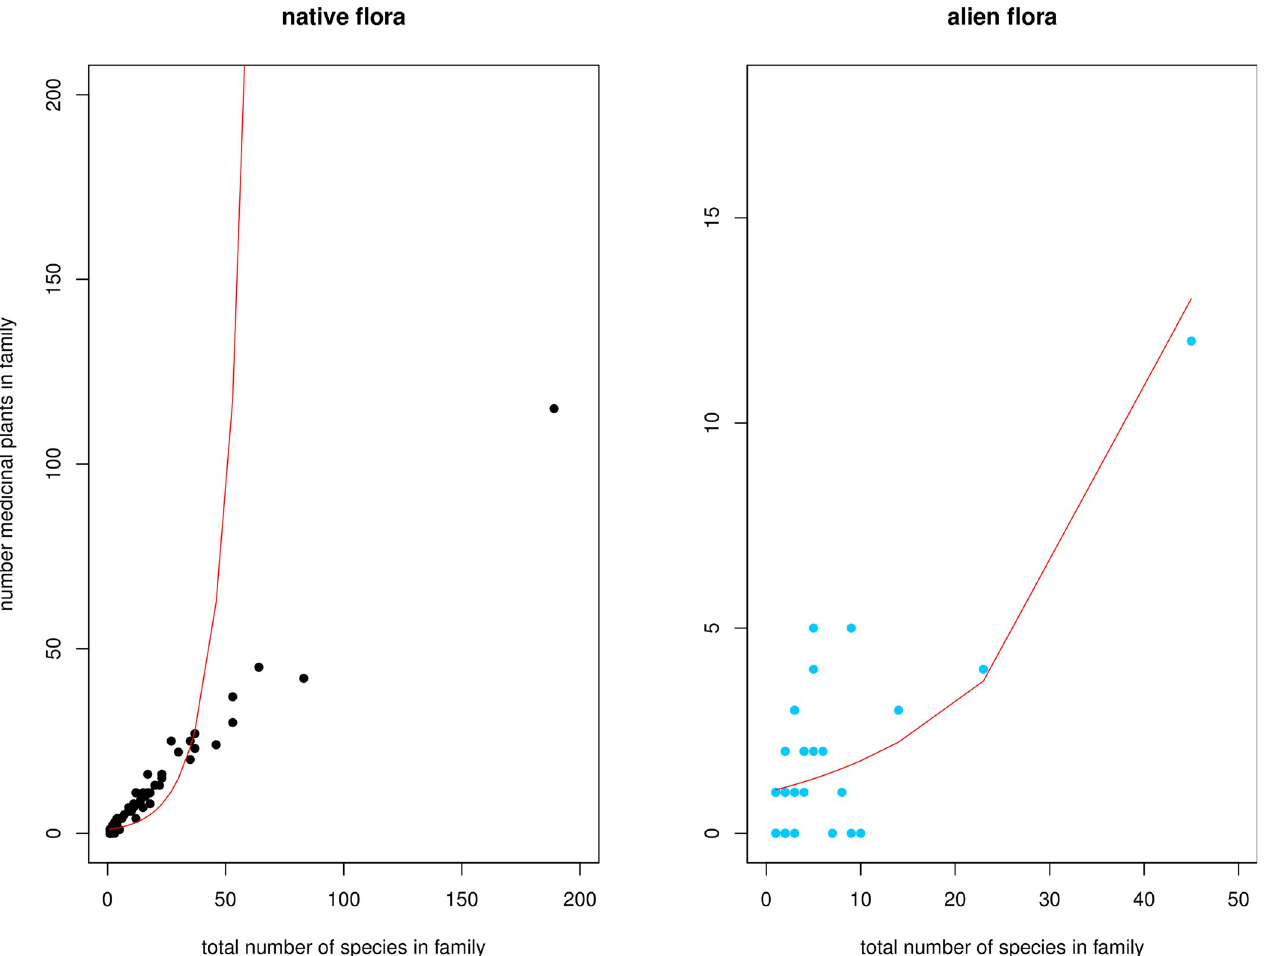
Fig 1. Relationship between number of medicinal plant species and total number of species in native and alien flora of southern Africa. The red line is the fit line following a negative binomial model. Each dot above the fit line represents an over-utilized family, and each dot below the red line represents an under- utilized family. Over-utilized family = family that contains more medicinal plants than expected, given the model fitted; Under-utilized family = family that contains less medicinal plants than expected.